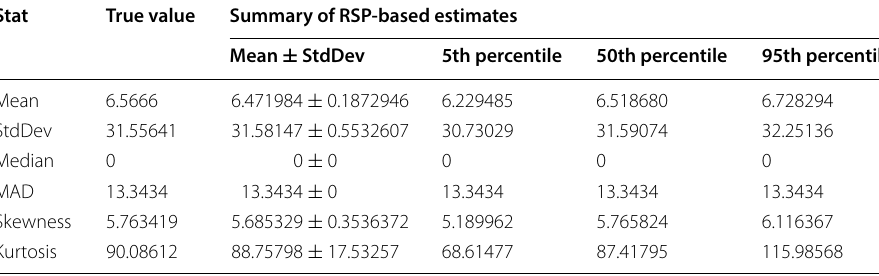
RSP-based estimates were calculated from a sample of RSP blocks ( g = 10 )